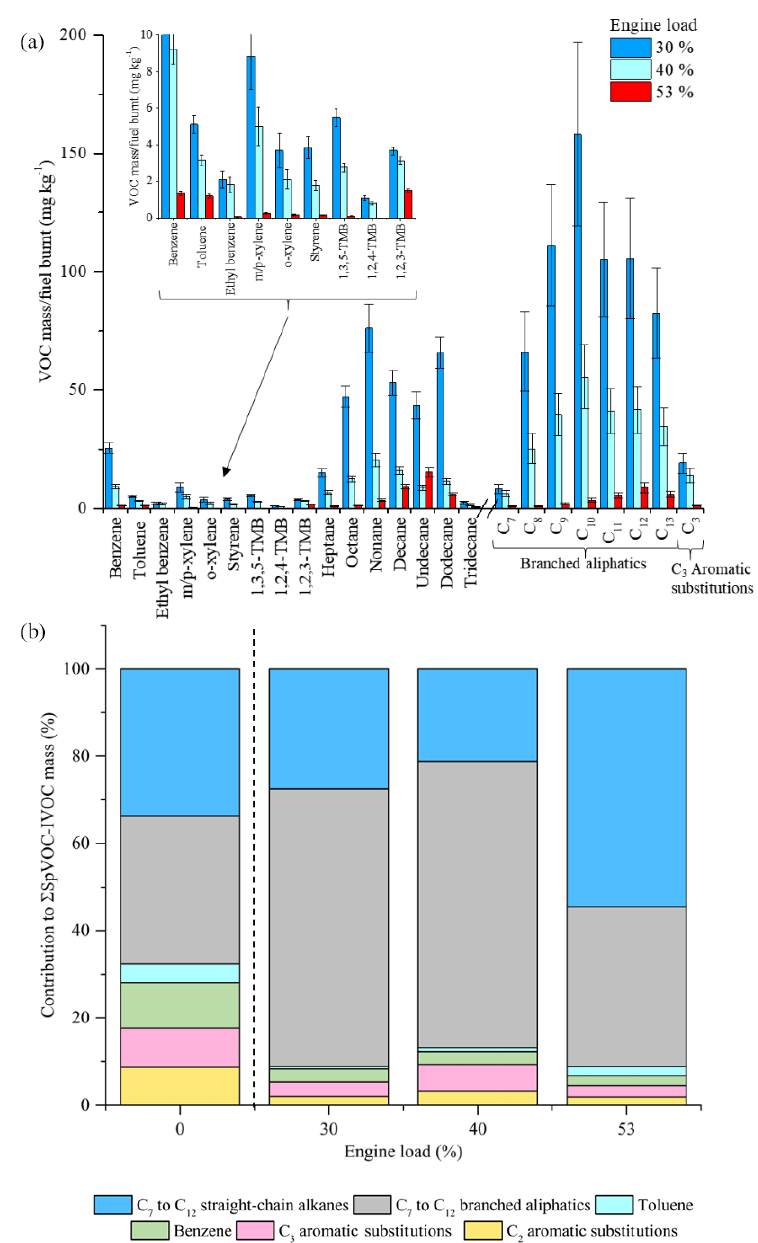
Figure 10. Effect of different engine loads on measured VOC-IVOC emission rates (a) and the percentage contribution of the individual and grouped compounds to the P SpVOC-IVOC emission rate at 0 (exp. 14), 30 (exp. 12), 40 (exp. 13, and 53% (exp. 11) engine load (b) . The emission rates of tridecane and the C 13 branched aliphatic grouping have not been included in (b) to allow direct comparison between other experiments where these species were not measured. For comparison, the percentage contribution of the individual and grouped compounds to the P SpVOC emission rate in a cold idle experiment (exp. 14) has been included on the left of (b) , see text for further details. Error bars represent the calculated uncertainty in the measured emission rates, see Sect. S1.1 for further